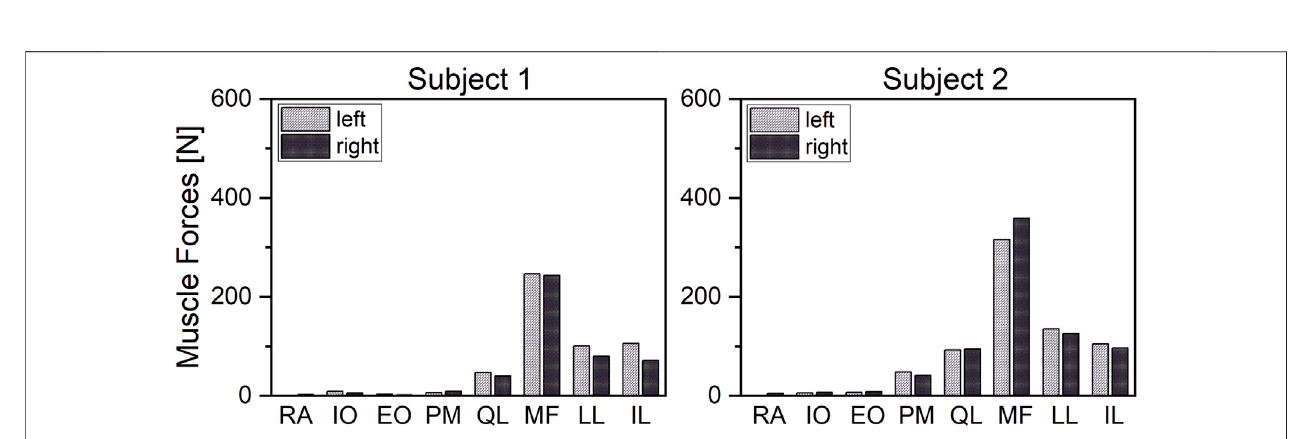
FIGURE 11 | Comparison of interindividual muscle forces at 20 ° fl